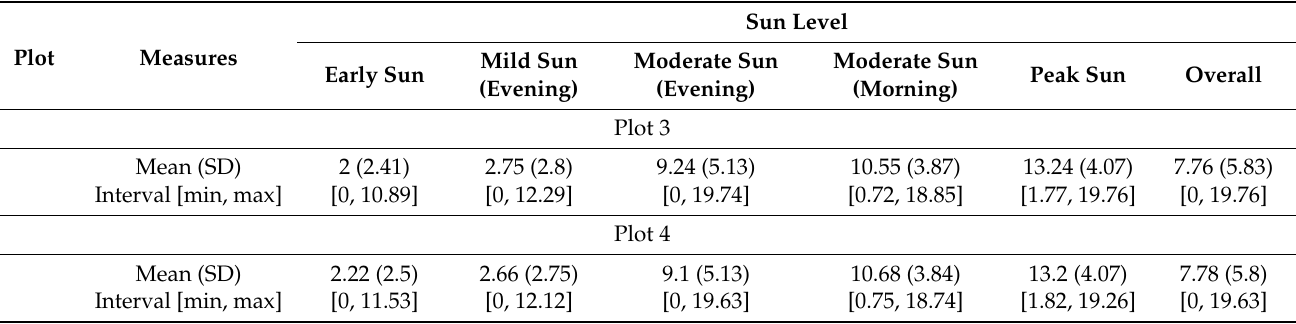
Table A1. Descriptive statistics of energy at different sun levels and